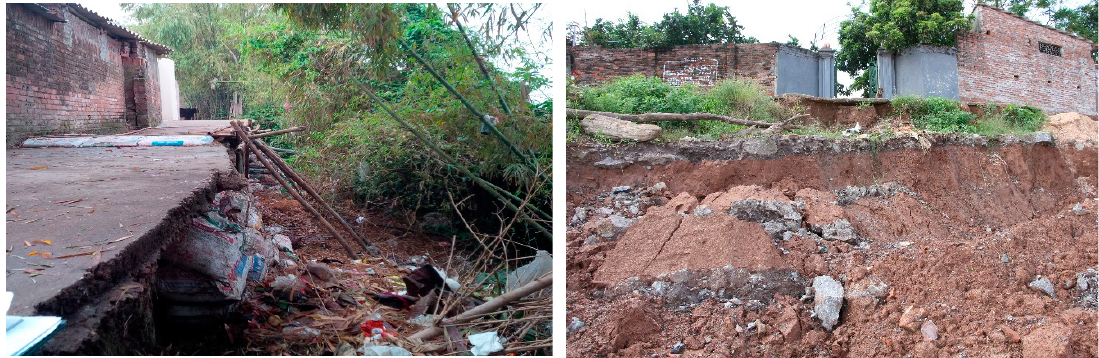
Figure 1. Some current problems near the riverbank in the study area.